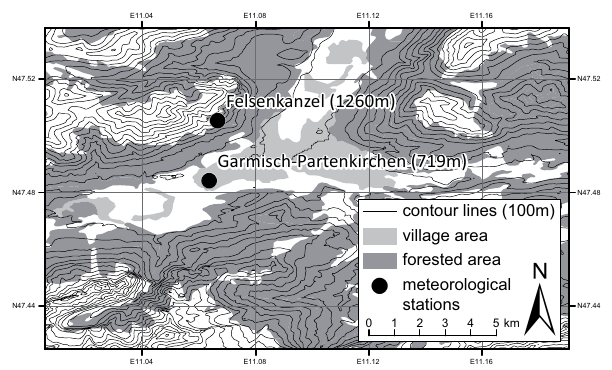
Fig. 2. Elevation, forested area, human settlements and locations of the meteorological stations in the study